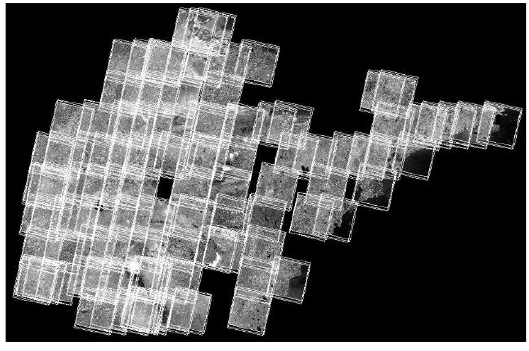
Figure 1. Satellite image distribution map of